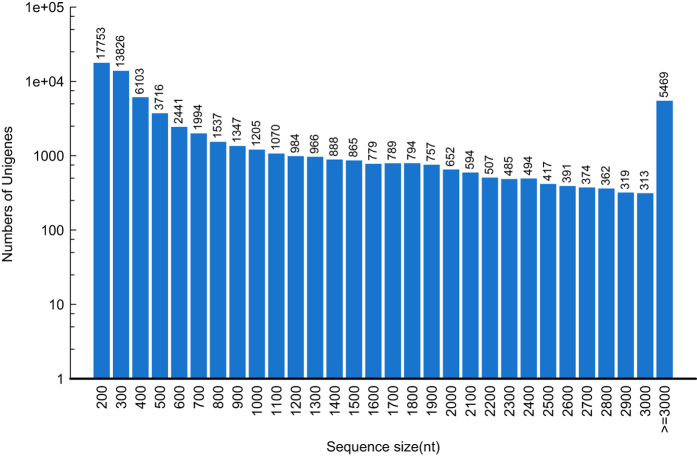
Length distribution of unigenes.The x-axis indicates the lengths of unigenes, and the y-axis indicates the number of unigenes.